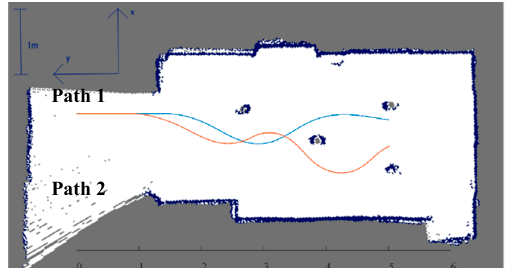
Figure 19. The experimental setup for operating a mobile robot in a cluttered environment ( upper : the photo, lower : the mapping) and two resulting obstacle-avoiding navigation paths generated online by the streamline-based approach.